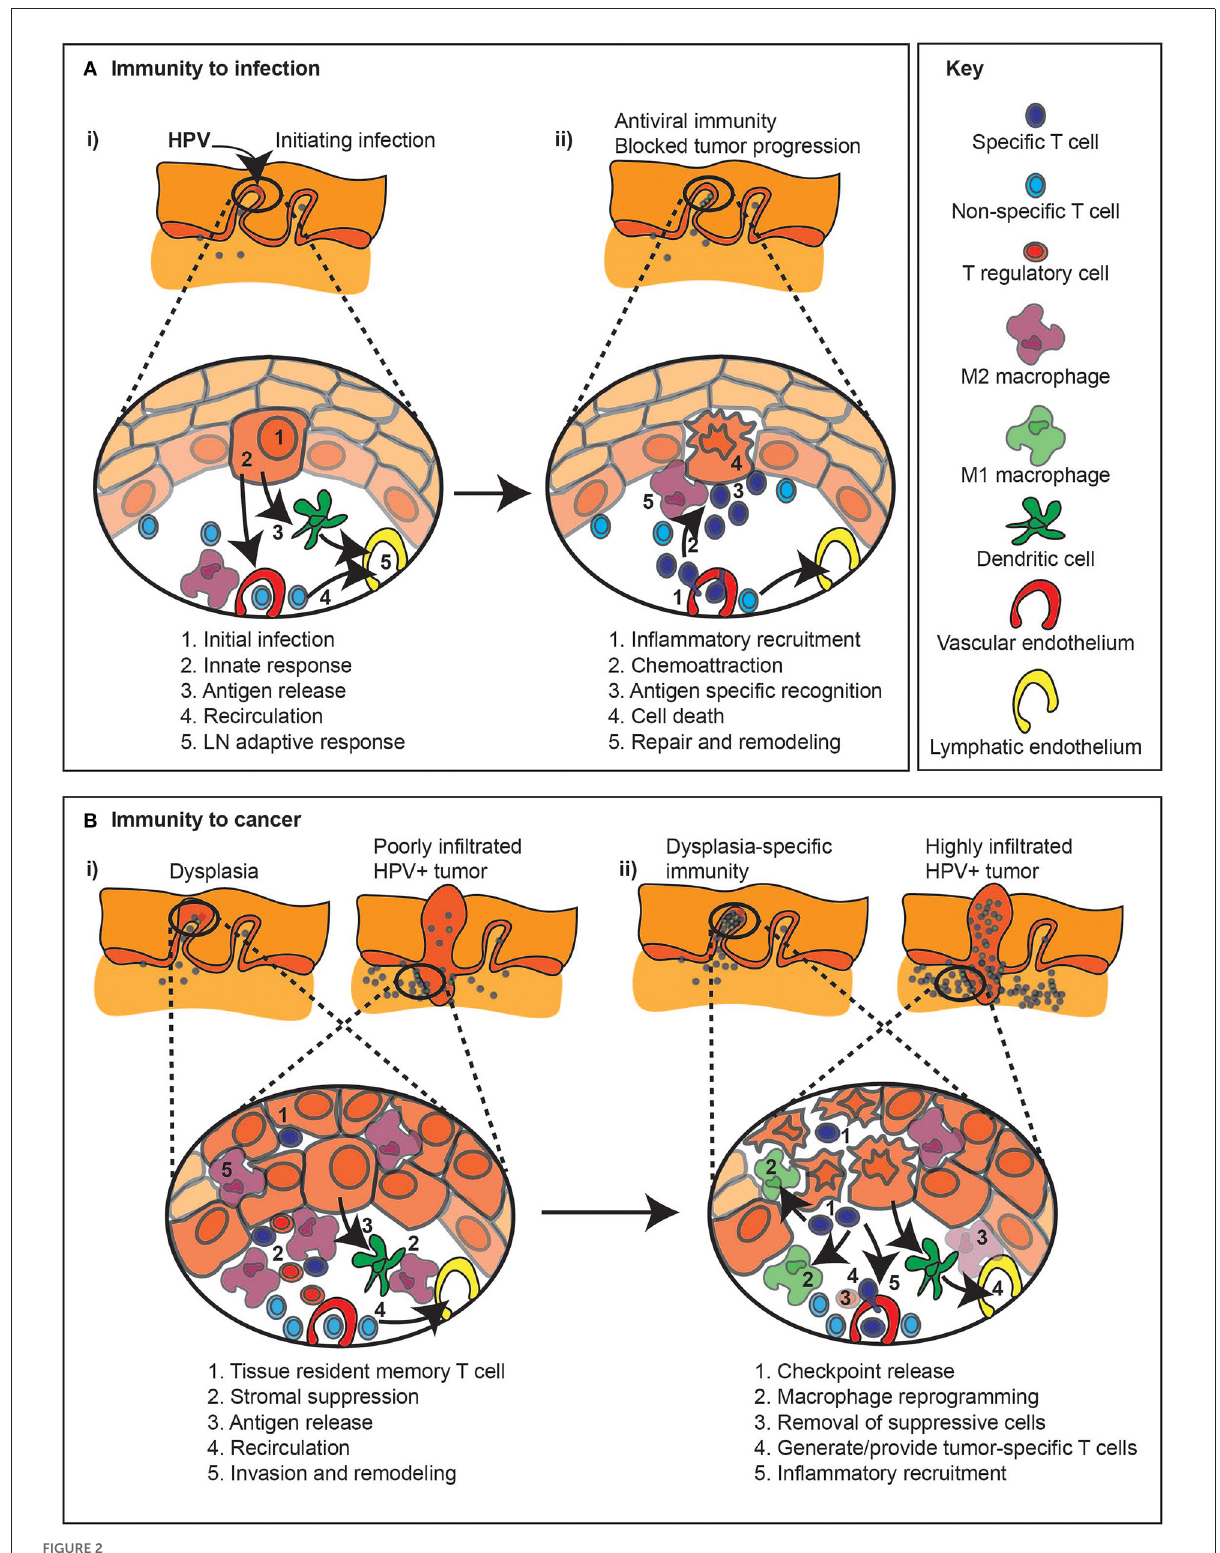
FIGURE2 Immune regulation during infection and related immunotherapy effects on pre-existing anti-tumor immune responses. (A) (i) The response to an infection, in this example HPV infection of basal epithelial cells (1), can result in a series of events that result in immunity. Innate sensing